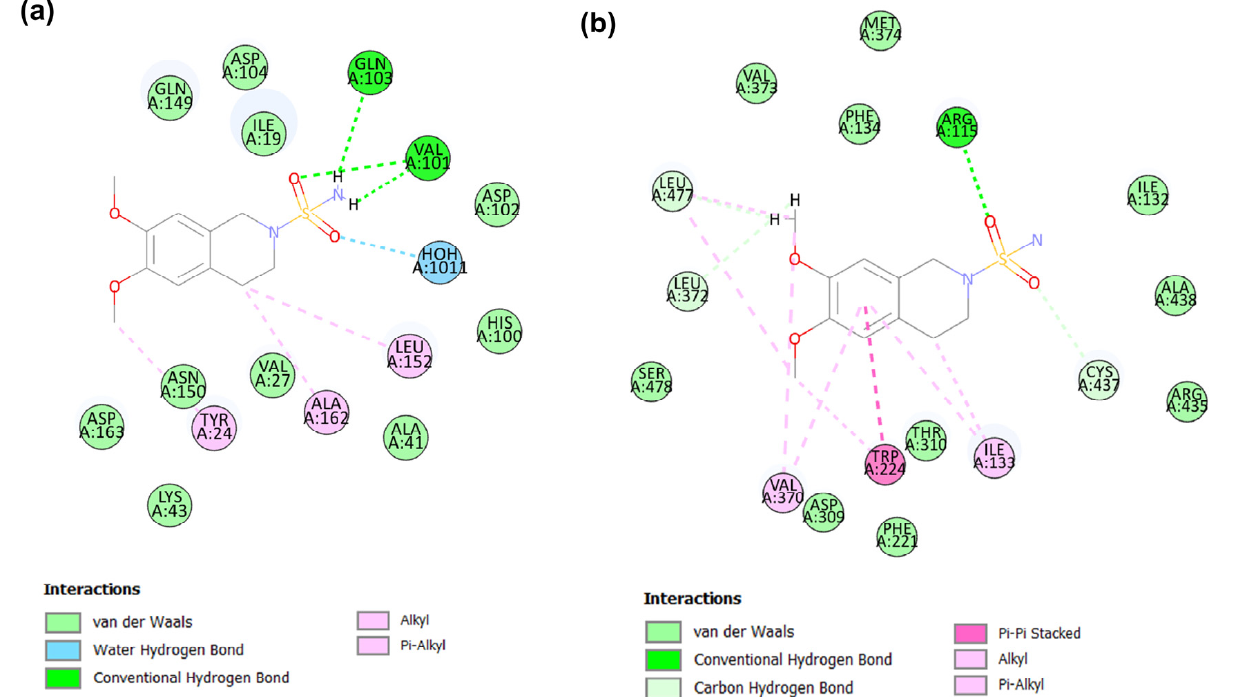
Figure 10. The 2D plot of candidate 4 in CDK ( a ) and aromatase ( b ) at the binding site. The C1 of 3,4-dihydroisoquinoline-2(1 H )-sulfonamide formed notable hydrophobic The molecular docking interaction between the aromatase and candidate 4 complex sulfonyl group of 3,4-dihydroisoquinoline-2(1 H )-sulfonamide of candidate 4 forms a